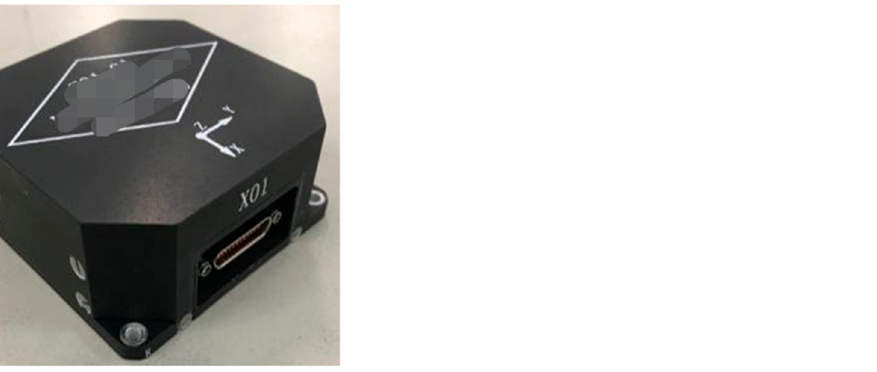
Figure 1. The navigation grade micro-electromechanical system (MEMS) gyroscope unit product.